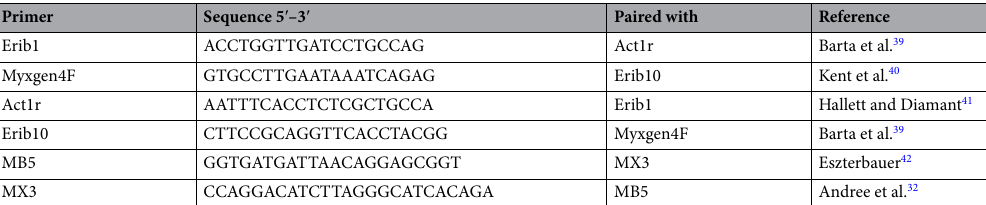
Table 3. Primers used for the amplification and sequencing of the ssrDNA of the new Henneguya spp. Cycling conditions (for all primers): Initial denaturation at 95 °C for 3 min, followed by 35 cycles of 95 °C for 1 min, annealing at 55 °C for 45 s, 72 °C for 2 min, and a final extension at 72 °C for 7